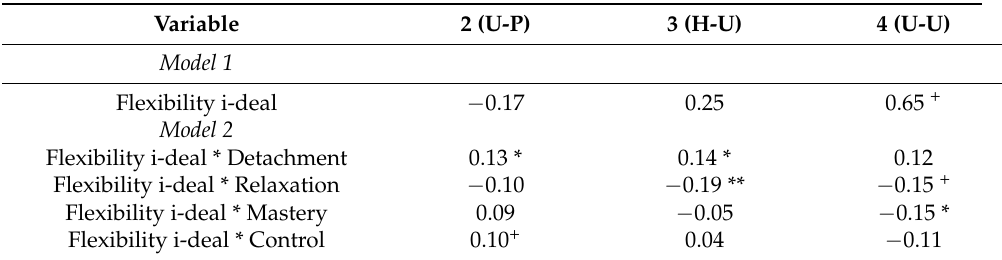
Table 6. Regression coefficients of Flexibility i-deal moderated by recovery on Emotions and Job Performance clusters (Study 2; N =